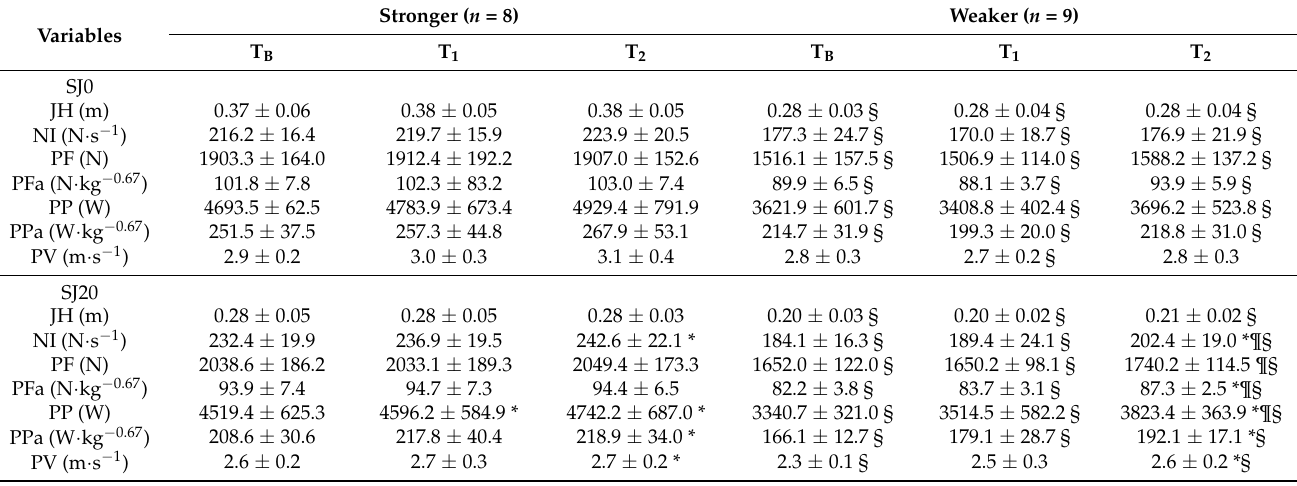
Table 4. Changes of selected squat jump and sprint variables in stronger and weaker